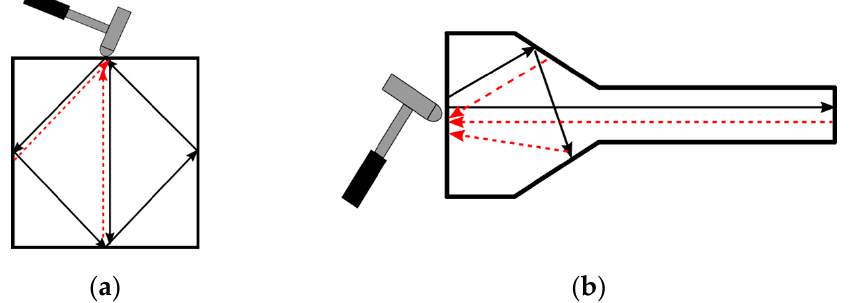
Figure 5. Schematic of the propagation path of multiple reflection: ( a ) Rectangular cross-section; ( b ) Complex shaped beam.